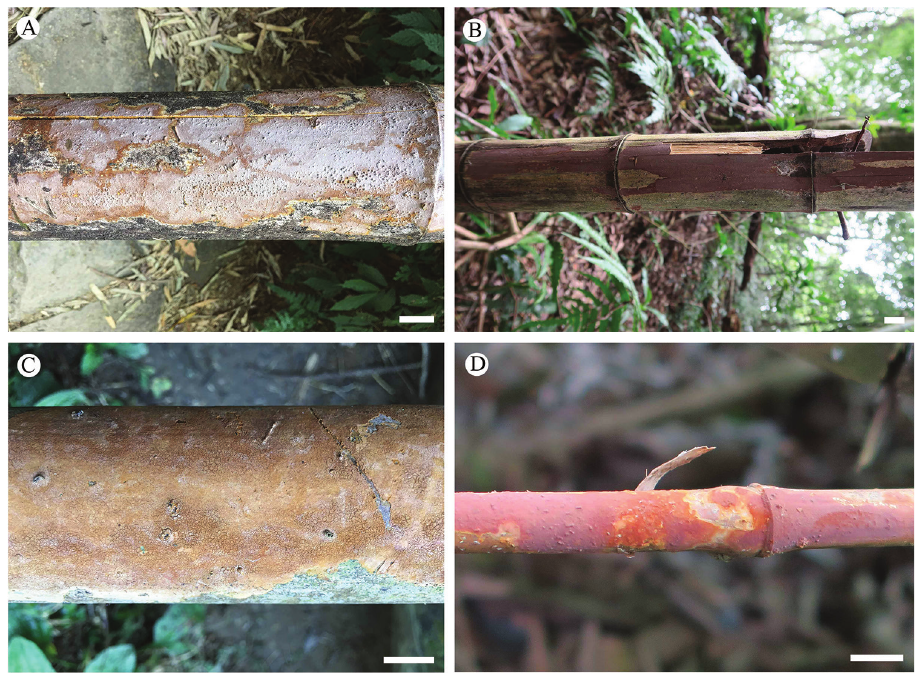
Figure 6. Basidiomes of previously known Hymenochaete species on bamboos from East Asia. A H. innexa (He 4640) B H. muroiana (He 4608) C H. rhabarbarina (He 4636) D H. tropica (He